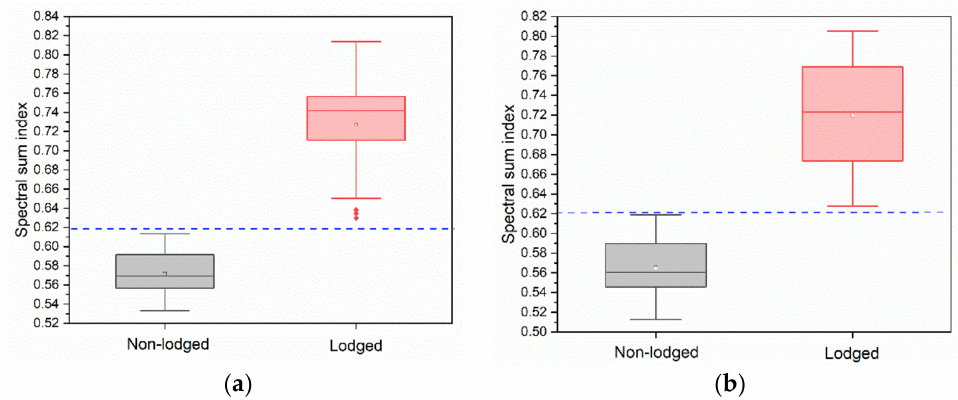
Figure 5. The value of spectral sum calculated according to the training samples for lodged and non-lodged maize in ( a ) Zhaodong City and ( b ) Ningjiang District. The value pointed by the blue dotted line represents the appropriate threshold to discriminate lodged and non-lodged